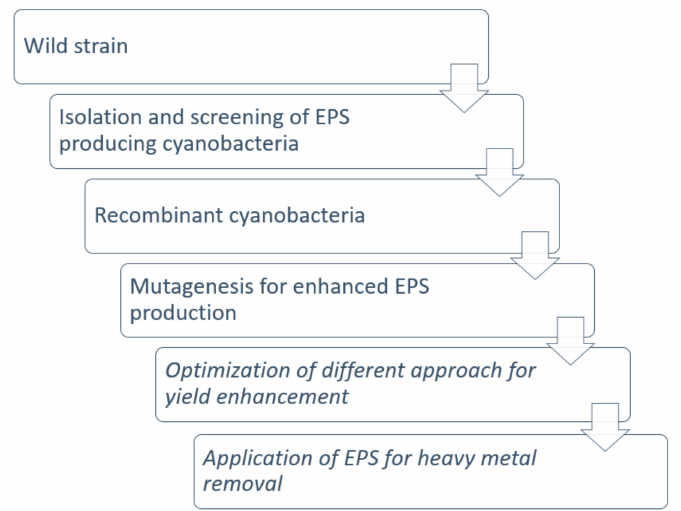
Figure 6. Stepwise process strategy for enhancing the extracellular polymeric substances (EPS)